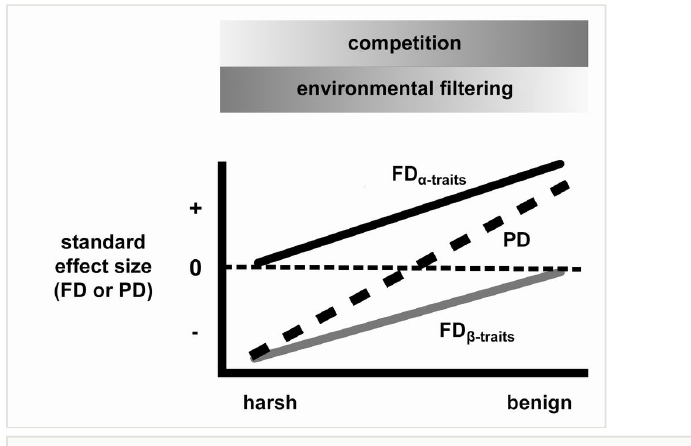
Prediction of the Stress Dominance Hypothesis for FD , FD , and PD. Horizontal axis represents a gradient of environmental stress. At the harsh end of the gradient, environmental fi ltering is strongest, so PD is clustered (negative standard e ff ect size). At the benign end of the gradient, competition becomes more important and results in coexistence of functionally and phylogenetically distinct taxa. Thus PD is overdispersed (positive